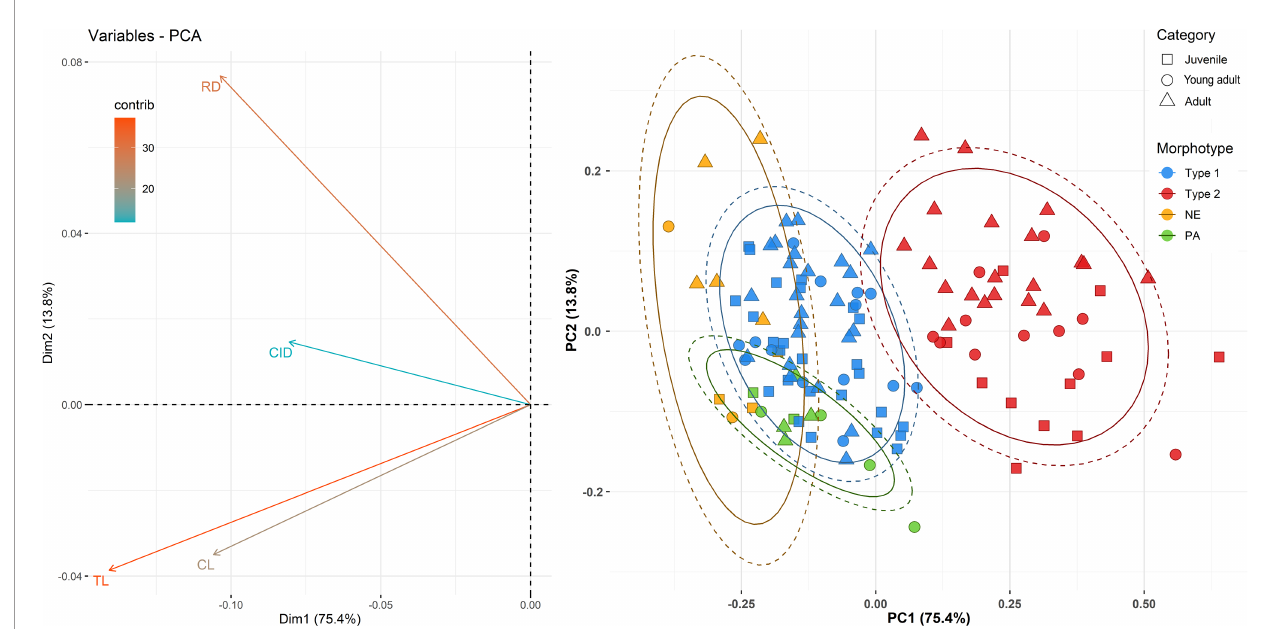
FIGURE 6 | Principal component analysis for teeth measurements obtained from samples of Sotalia dolphins from North and Northeastern Brazil. Left: Contribution of the variables total length (TL), root diameter (RD), crown length (CL), and cingulum diameter (CID) to the principal component dimensions (PCs). Right: Scores distribution in the two dimensions of the PCs. The category indicates juveniles, young adults, and adults in the sample, and colors indicate the teeth morphotypes or species. The localities of Para ́ coast (PA) and Northeast Brazil (NE) included only stranded specimens of Sotalia guianensis